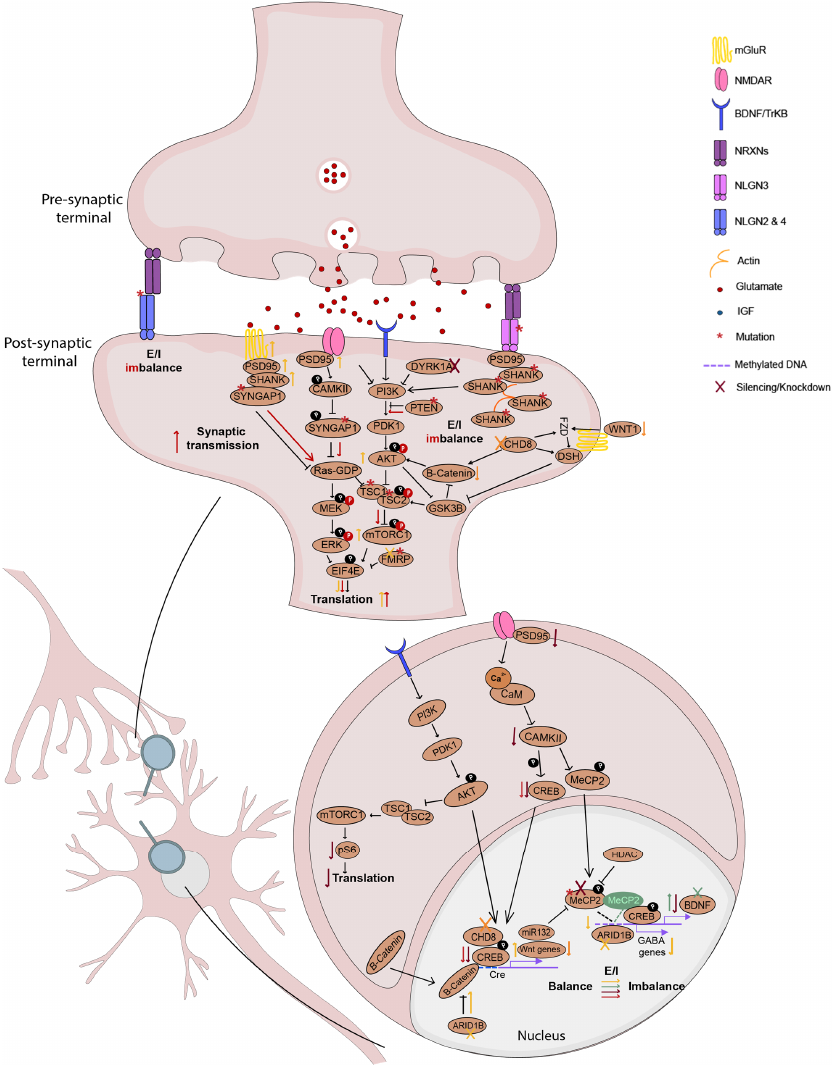
Figure 3. NDD convergent molecular pathways. Simplified schematics of the major components known to be altered in NDDs. Mutations in some of the genes encoding these proteins may trigger altered protein translation and synaptic imbalances that culminate in the neuronal deficits already described in several NDDs. In the cytoplasm, PI3K/mTOR and MEK/ERK pathways, which regulate protein translation, are hyperactivated in response to mutations in PTEN , TSC1/2 , NRXN s, NLGN s, FMRP , SYNGAP1 and DYRK1A , leading to abnormal protein production and synaptic malfunction; CHD8 mutations also contribute to this dysfunction through dysregulation of the cytoplasmic Wnt signaling. Additionally, mutations in transcriptional regulators and chromatin remodelers ( CHD8 , ARID1B , MECP2 ) favor/diminish the expression of genes that encode key proteins (Wnt signaling-associated genes, BDNF , GABAR genes) or alter their expression ( MECP2 ), triggering excitation/inhibition (E/I)